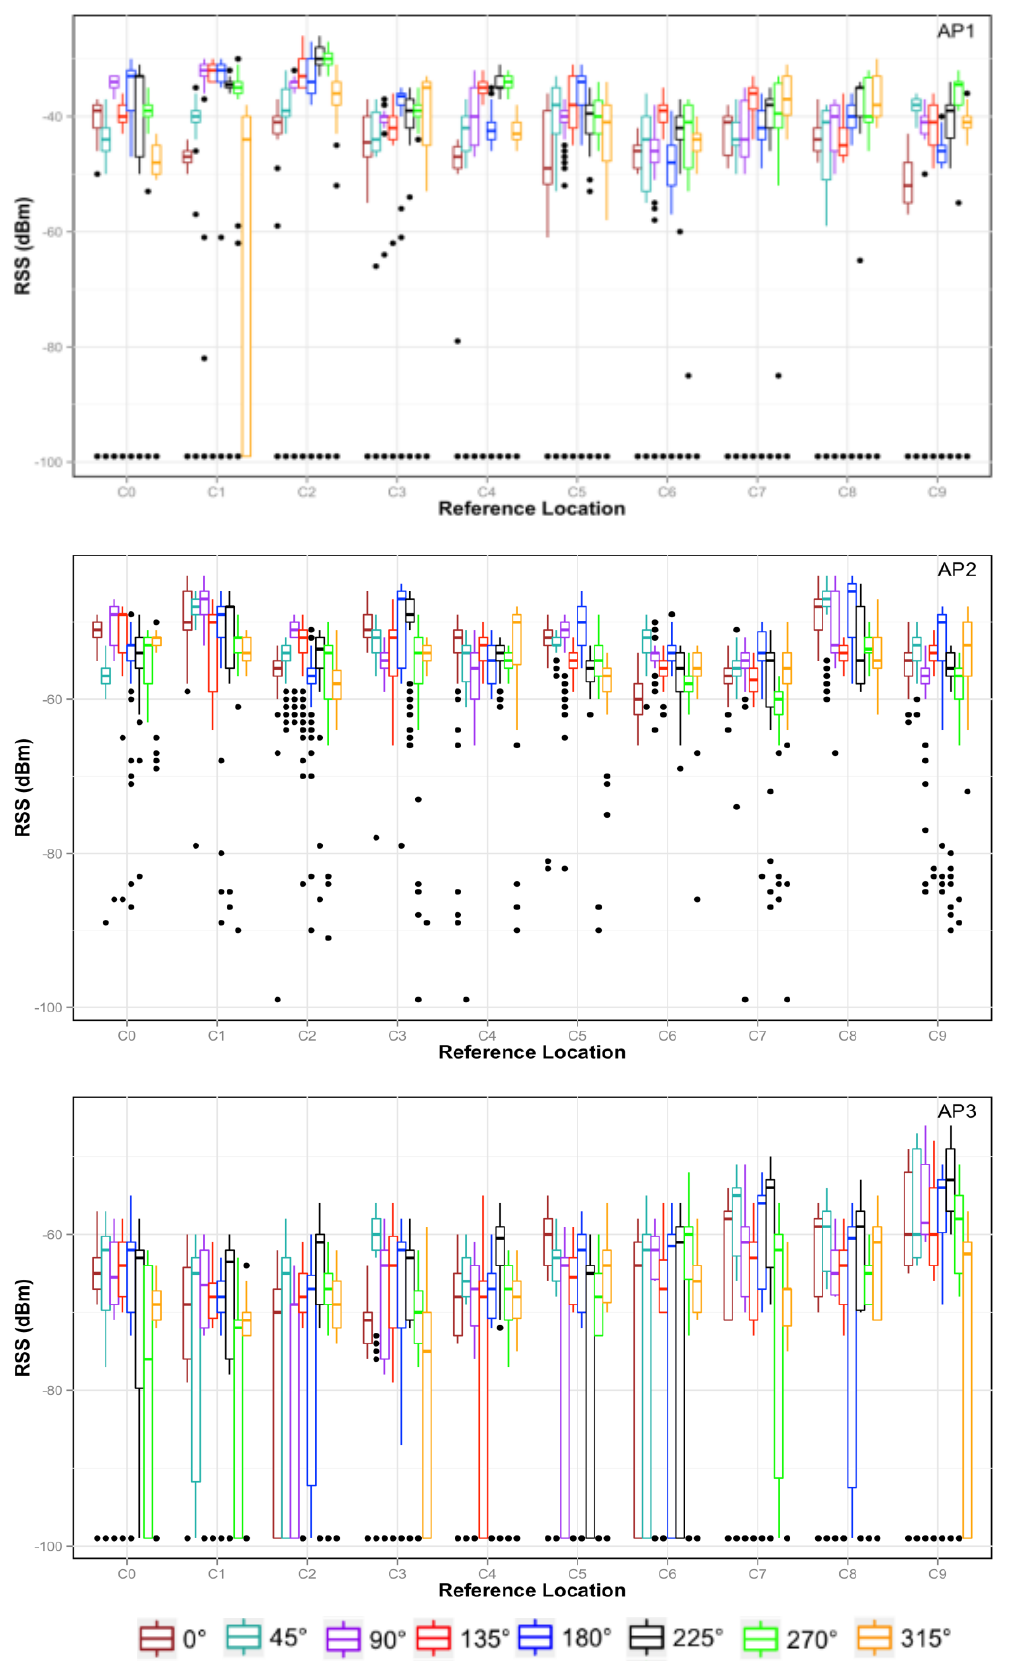
Figure 4. Data distribution for ten locations and the AP1, AP2 and AP3 access